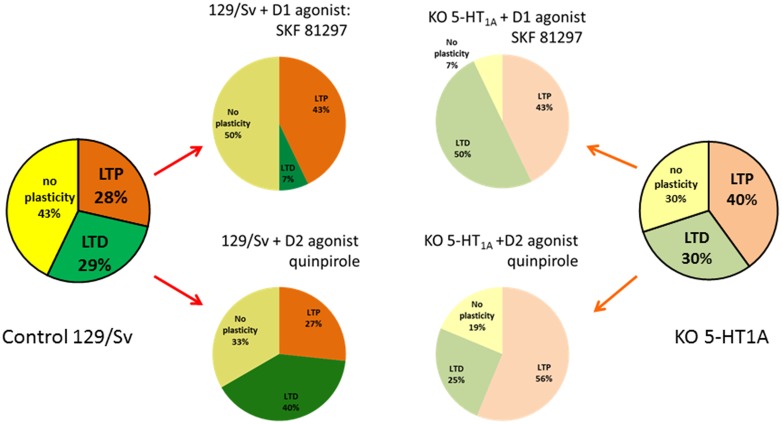
Schematic summary of the orientation of the plasticity in L5PyNs of the PFC. Ratio of L5PyNs displaying LTP, LTD or no plasticity calculated 45 min after HFS under different conditions. In each case, the analysis of the neuronal population results from 15 independent experiments. Left and right charts were obtained from control 129/Sv mice or from 5-HT1AR-knock out (5-HT1AR-KO) mice. Note that the ratio of L5PyNs displaying LTP was significantly increased in 5-HT1AR-KO mice (see Meunier et al., 2013). In 129/Sv mice, the D1-like receptors (D1Rs) agonist, SKF 81297, markedly reduced the proportion of L5PyNs displaying LTD while it enhanced the ratio of L5PyNs displaying LTP (Meunier et al., 2015). The D2Rs agonist, quinpirole, markedly increased the ratio of L5PyNs displaying LTD (from Meunier et al., 2017). In 5-HT1AR-KO mice, the D1Rs agonist, SKF 81297, markedly increased the proportion of L5PyNs displaying LTD while it reduced the ratio of L5PyNs displaying LTP. Activation of D2R with quinpirole had no significant effect on the ratio of L5PyNs displaying LTD.